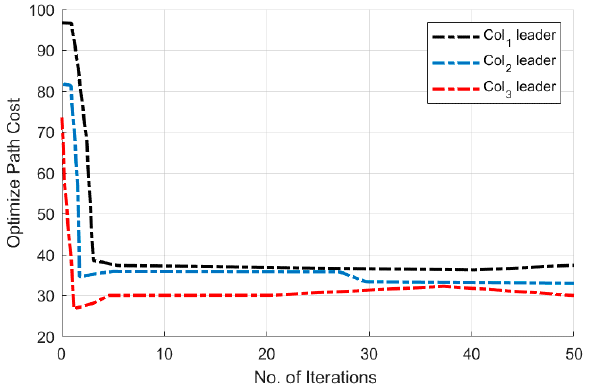
Figure 7. Optimization Costs for Case Study I.